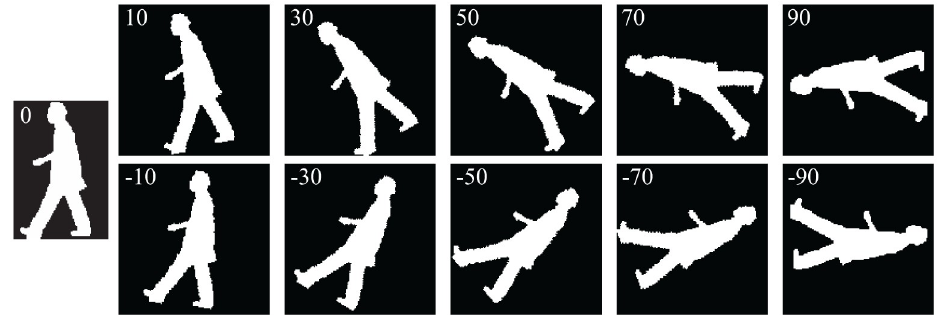
Fig 10. Examples of rotated images (0, 10, 30, 50, 70, 90, -10, -30, -50, -70, -90 degree).